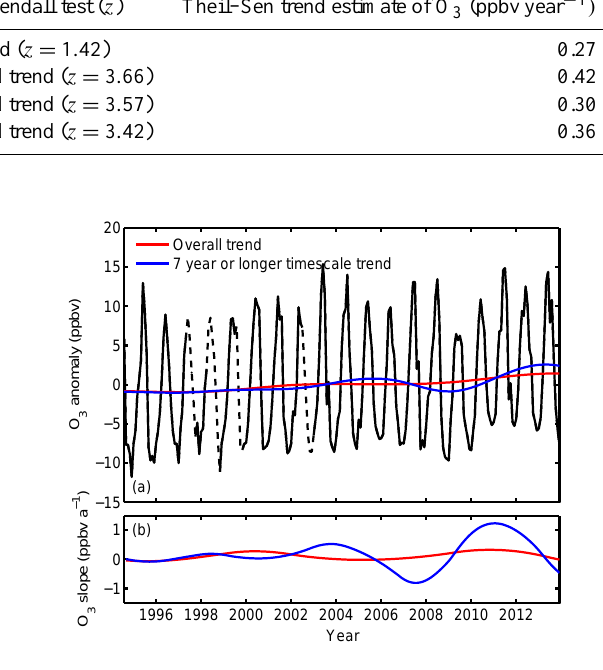
Figure 7. (a) The anomaly of the interpolated monthly average ozone (black line, with the dashed line segments representing val- ues interpolated using the method in Sect. 2.5), the sum of last IMF and the residual (c5 + r, red line), and the sum of the last two IMFs and the residual (c4 + c5 + r, blue line); (b) the slope of the sum of last IMF and the residual (c5 + r, red line) and the sum of the last two IMFs and the residual (c4 + c5 + r, blue